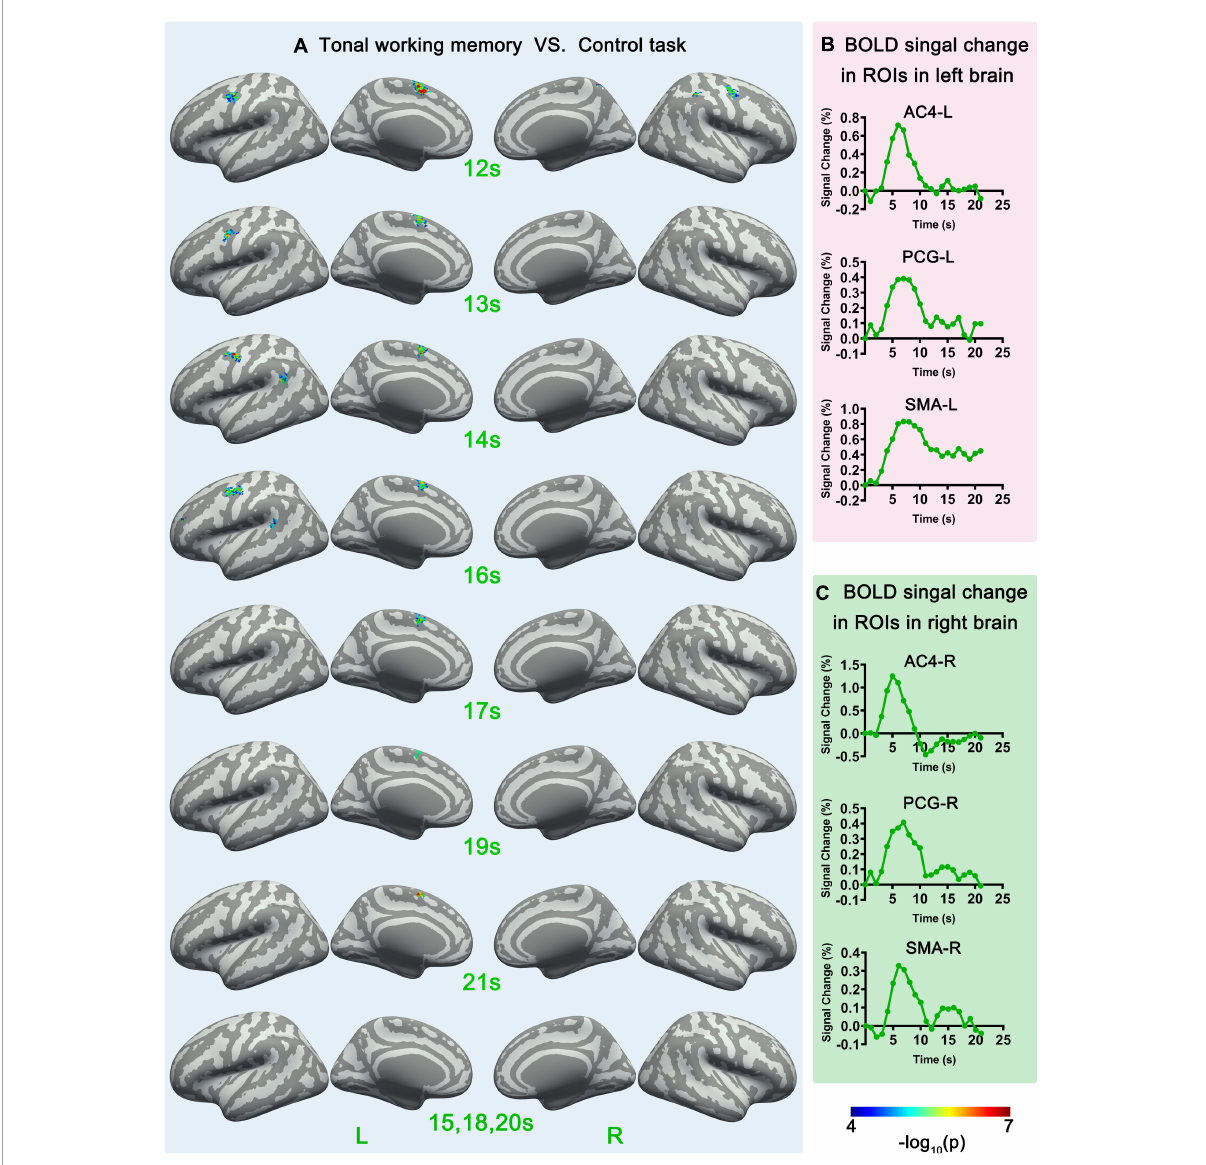
FIGURE4 Sf-MVPA analysis results of 12–21 s and BOLD curves of 6 ROIs. (A) The sf-MVPA results of 12–21 s of tonal working memory vs. control task. (B) Average BOLD curves of 3 ROIs in the left hemisphere. (C) Average BOLD curves of 3 ROIs in the right hemisphere. AC, auditory cortex; PCG, precentral gyrus; SMA, supplementary motor